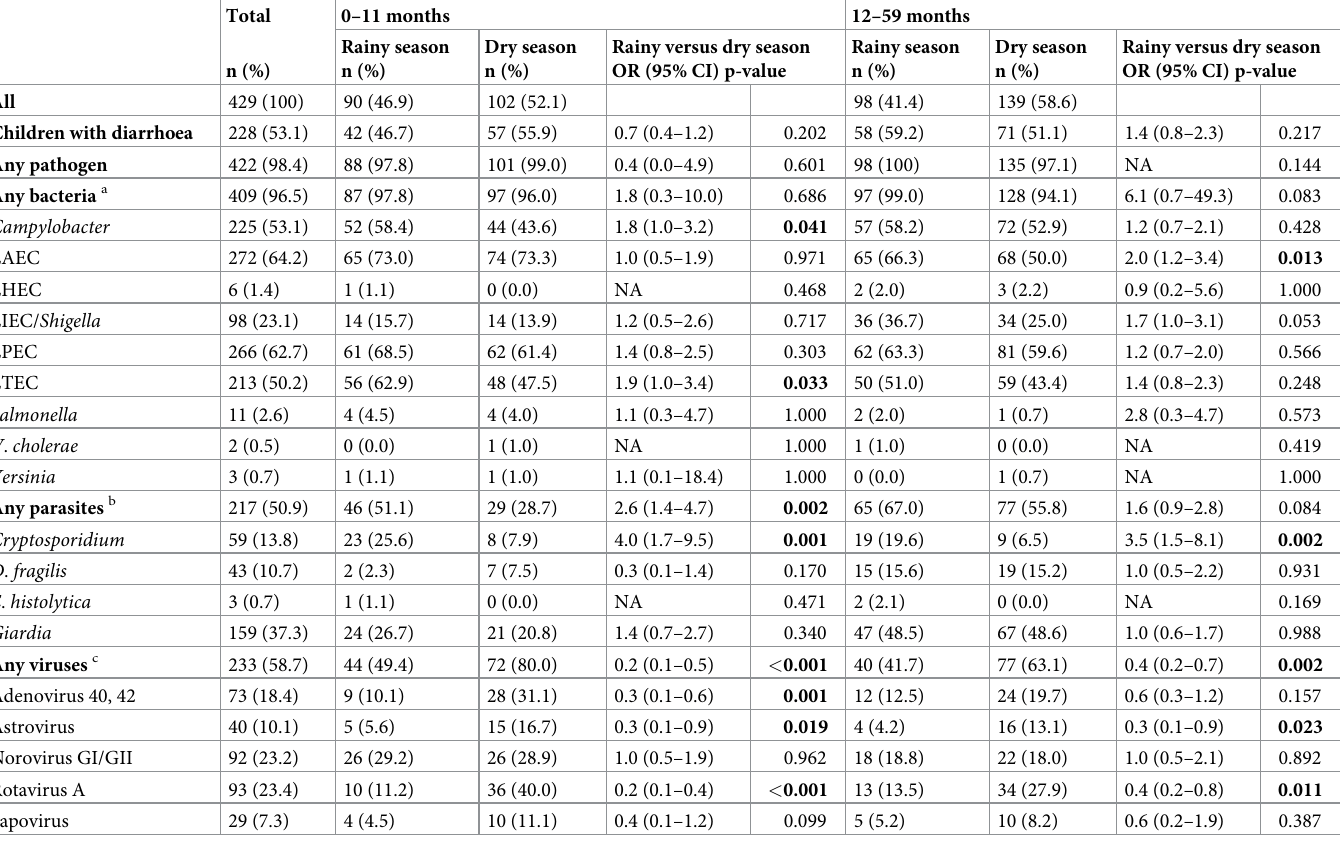
Table 2. Effect of seasonality on microbial findings by age